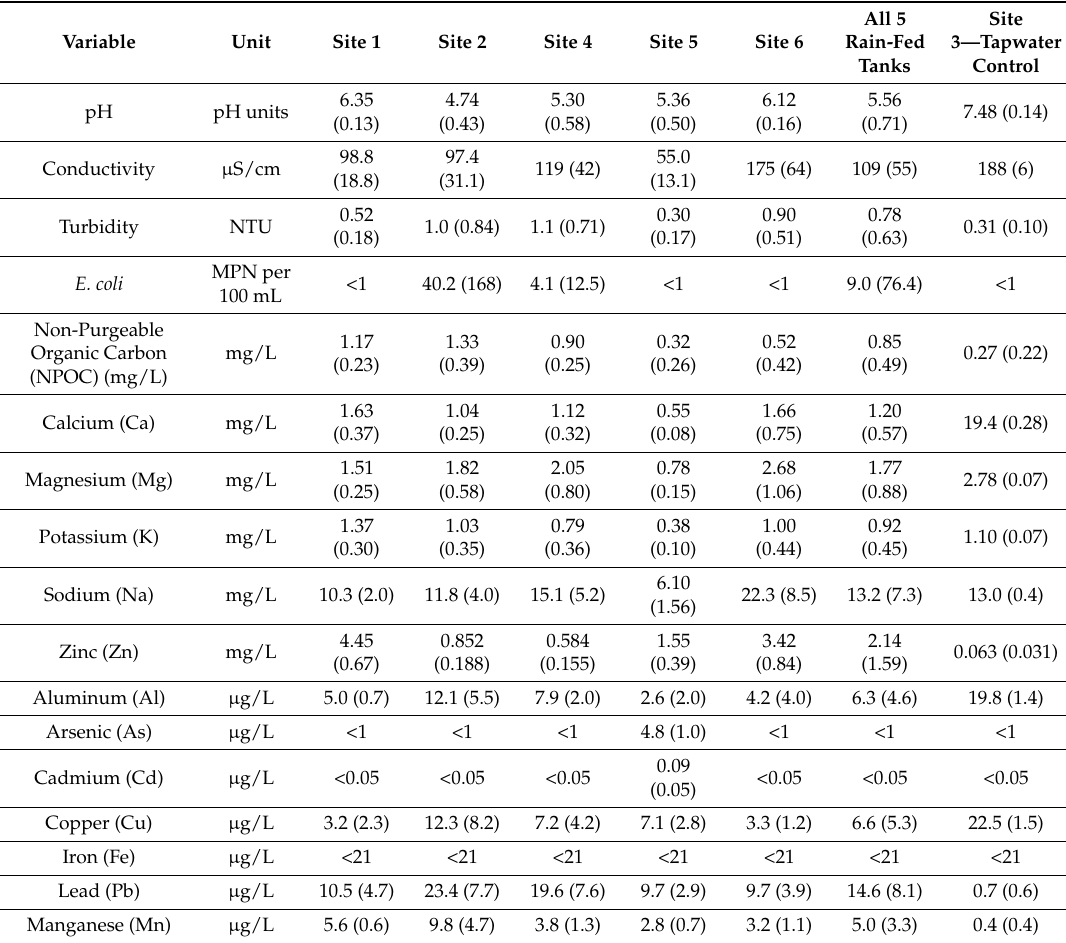
Table 4. Means and standard deviations (brackets) for measured variables in rainwater tanks. Sample numbers are given in